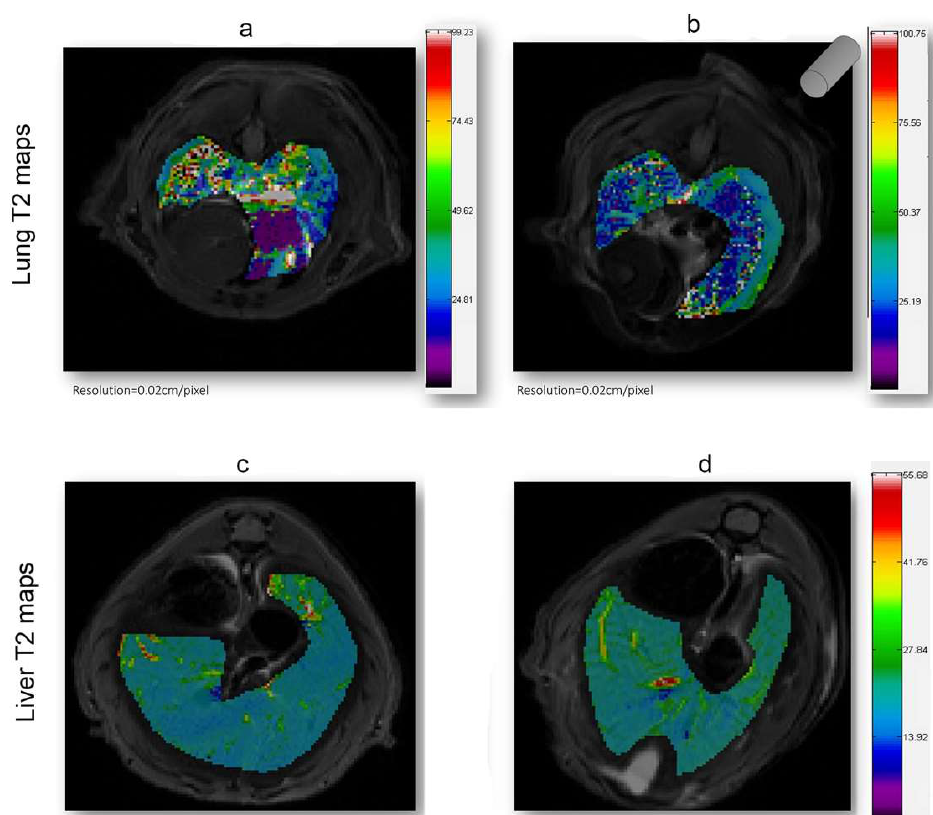
Figure 4. T 2 (ms) maps in the lung and liver ROI areas. A general reduction of relaxation time in EMHV-treated mouse ( b ) is visible in lung when compared with untreated one ( a ). No difference in relaxation time of both untreated ( c ) and EMHV-treated mice ( d ) is evident in the liver. Map resolution equal to 0.02 cm/pixel. The gray cylinder in ( b ) indicates the position of the magnet.